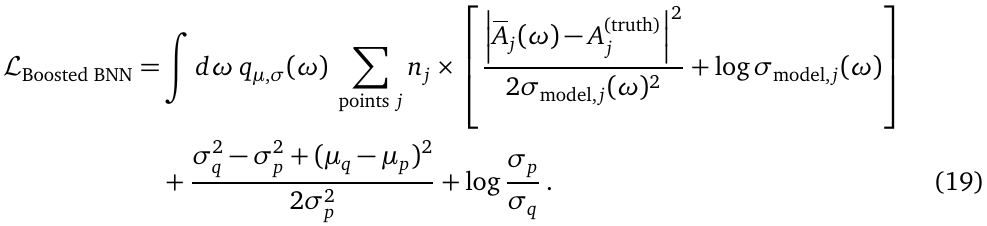
Figure 6: Pulls for the loss-boosted BNN, defined in Eq.(17) and evaluated on the training and test data. The two panels show the same results on a linear and a logarithmic axis. All curves can be compared to the BNN results without boosting in Fig. 4. times into the computation of the BNN